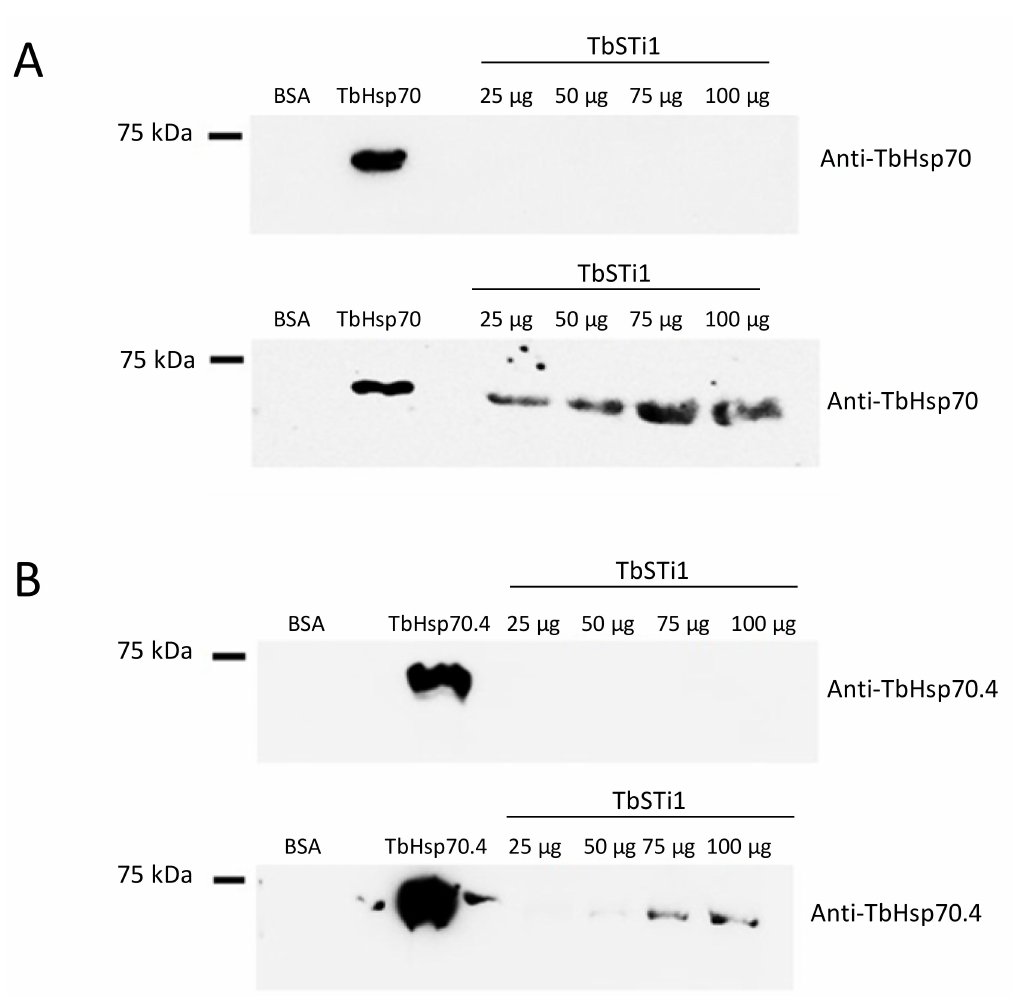
Figure 5. TbHsp70 and TbHsp70.4 directly interact with TbSTi1. Interaction between the TbHsp70s, TbHsp70 and TbHsp70.4 and TbSTi1 was investigated using far western analysis. TbHsp70 (50 µ g); control protein, BSA (50 µ g) and TbSTi1 at various concentrations (25 µ g, 50 µ g, 75 µ g, 100 µ g) were resolved by SDS-PAGE and transferred onto a blot and the blot was probed using rabbit polyclonal anti-TbHsp70.4 ( A ; top panel). A similar blot was then overlaid with TbHsp70 and it was probed using anti-TbHsp70 ( A ; bottom panel). ( B ) TbHsp70.4 protein (50 µ g); control protein, BSA (50 µ g) and TbSTi1 protein at various concentrations (25 µ g, 50 µ g, 75 µ g, 100 µ g) were resolved by SDS-PAGE and transferred to a blot and the blot was probed using rabbit polyclonal anti-TbHsp70.4 ( B ; top panel). A similar blot was then overlaid with TbHsp70.4 (75 µ g) and it was probed using anti-TbHsp70.4 ( B ; bottom panel). The blots are representative of independent